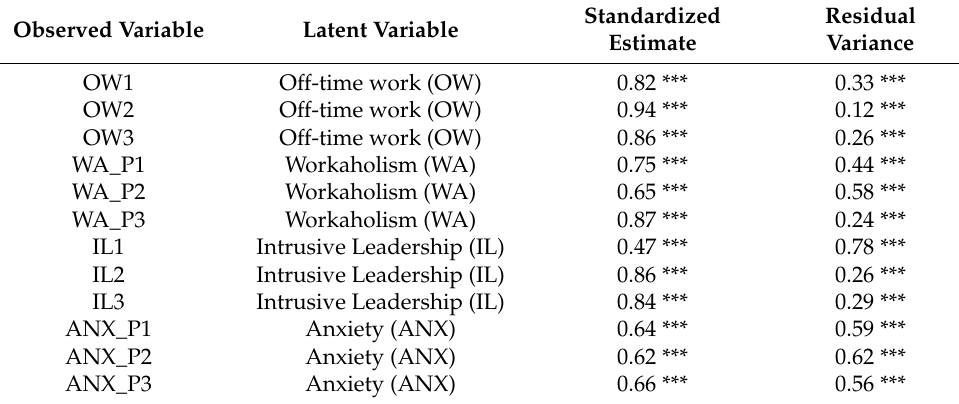
Table 1. Parameter estimates for the measurement model of the structural equation model in Figure